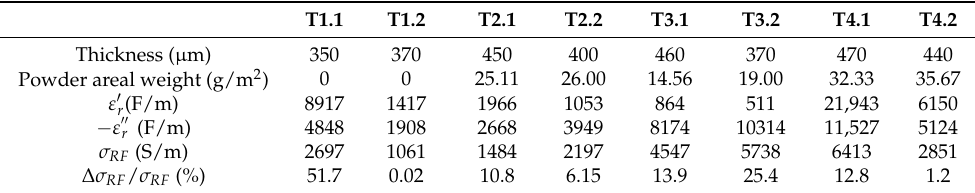
Table 5. Extracted complex permittivity and conductivity as a function of the powder areal weight— f = 10